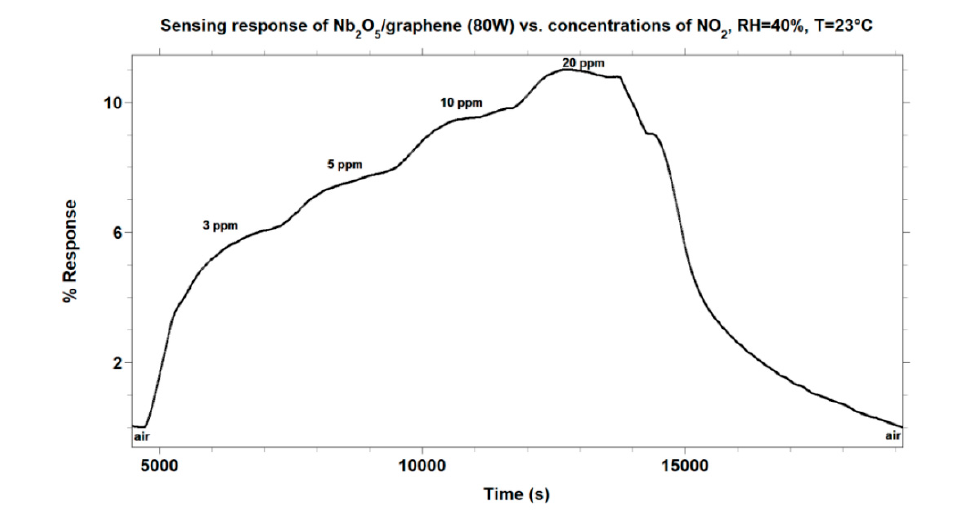
Figure 2. % Sensing response of a Nb 2 O 5 /graphene sensor (deposition electrical power 80 W) vs. 3, 5, 10, 20 ppm of NO 2 , in wet air (RH% = 40%, T = 23 °C).